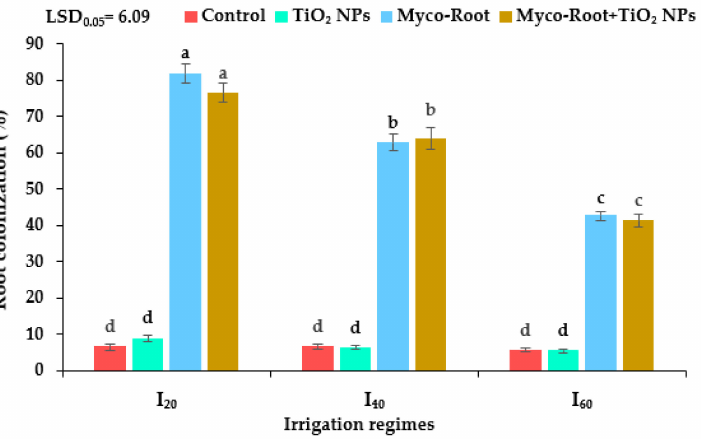
Figure 1. The effects of different irrigation regimes and fertilizer sources on the root colonization of peppermint. I 20 , I 40 , and I 60 indicating well-watered, mild, and severe drought stress, respectively. Different letters indicate significant differences at the 5% level according to LSD’s test.